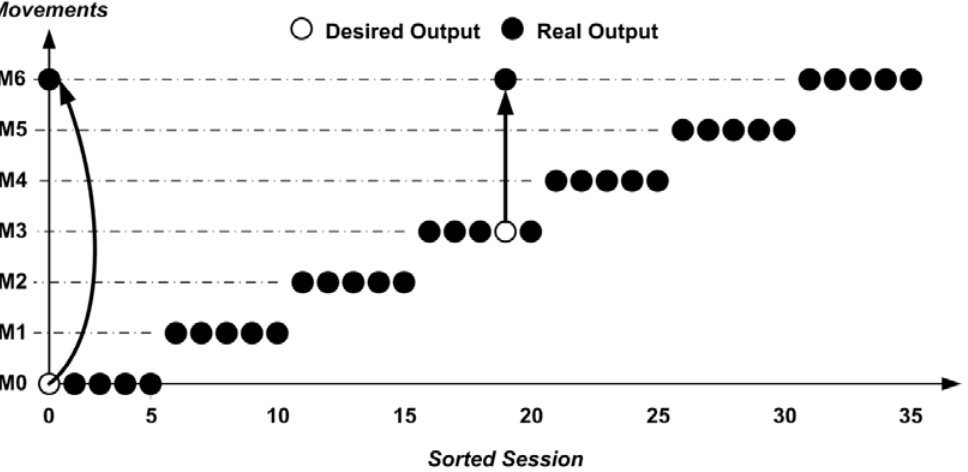
Figure 7. System output for Subject 1–Section 3 (5 repetitions).